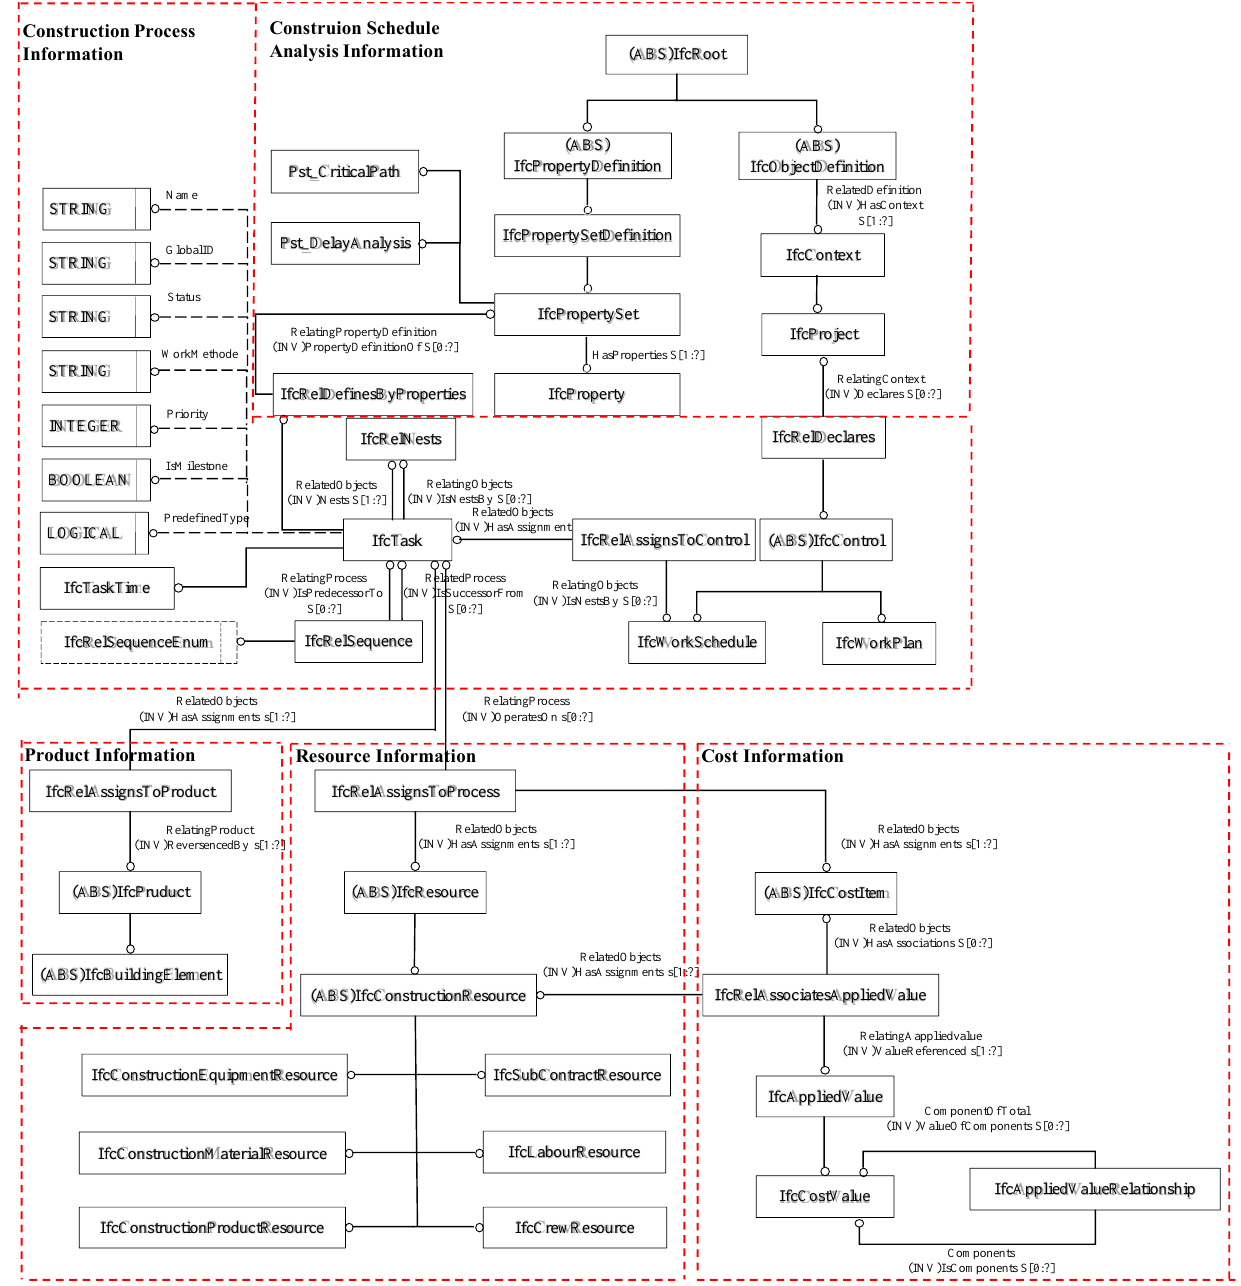
Figure 6. The IFC-based 4D construction management information model.